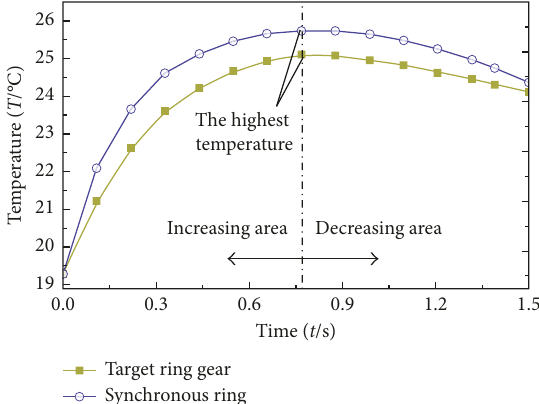
Figure 8: The highest temperature changing regularities of friction